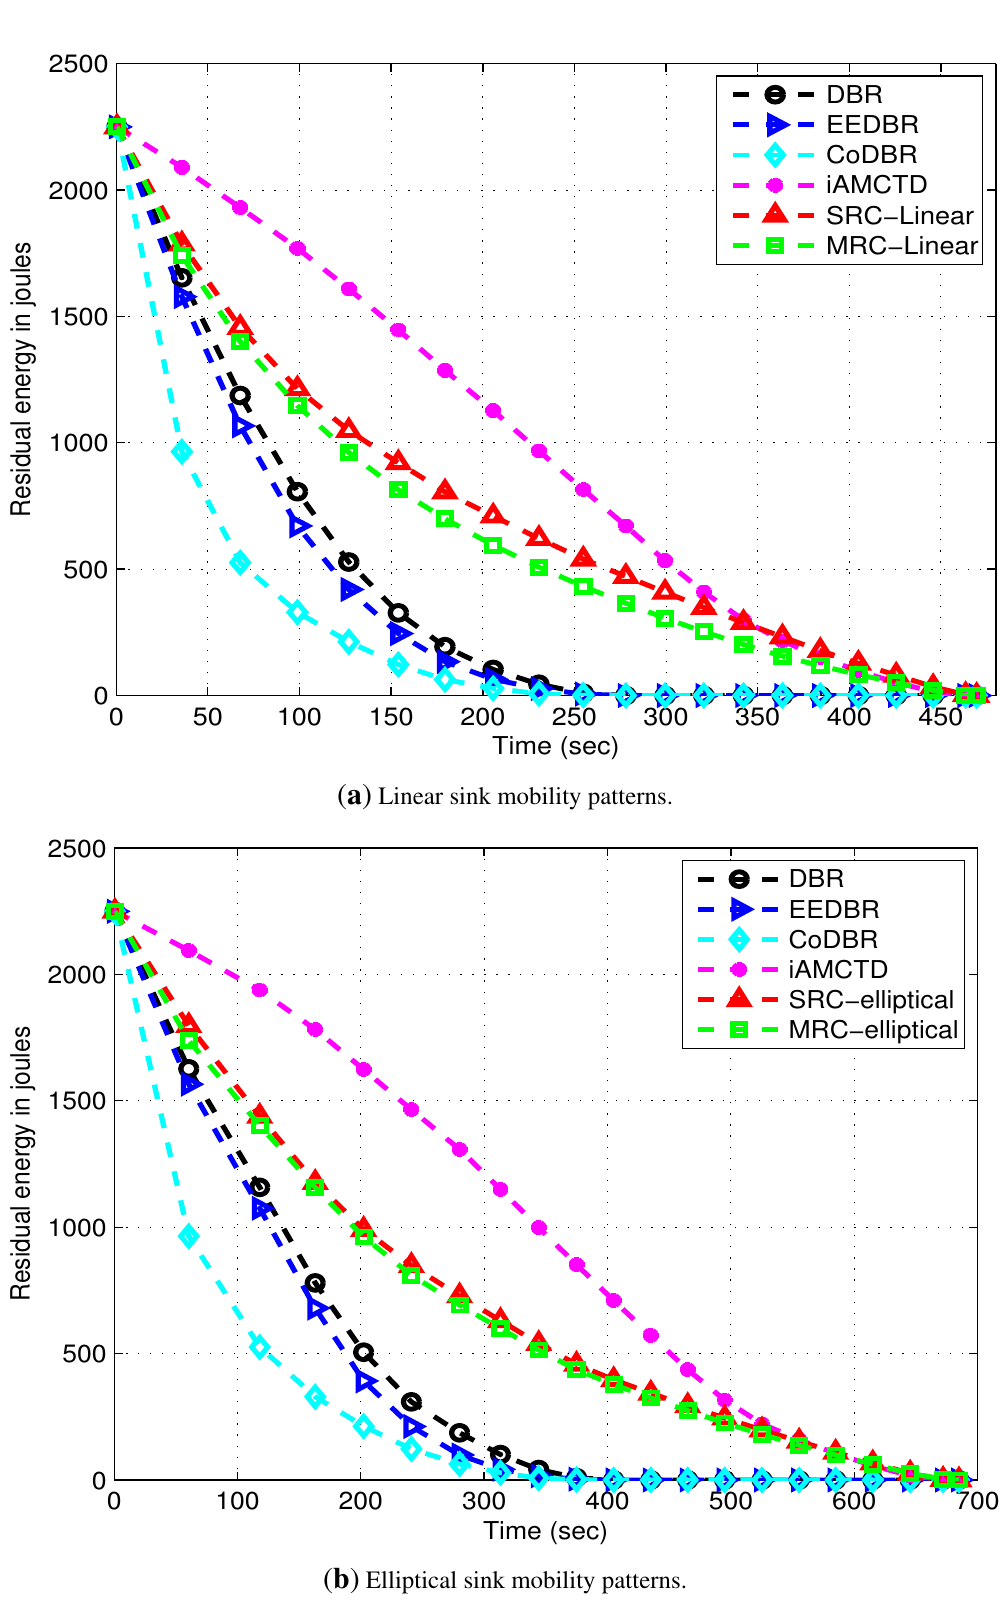
Figure 11. Residual energy possessed by the networks with linear and elliptical sink mobility